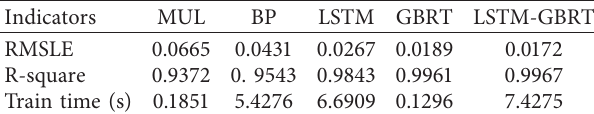
Table 8: Performance indicators of each model.